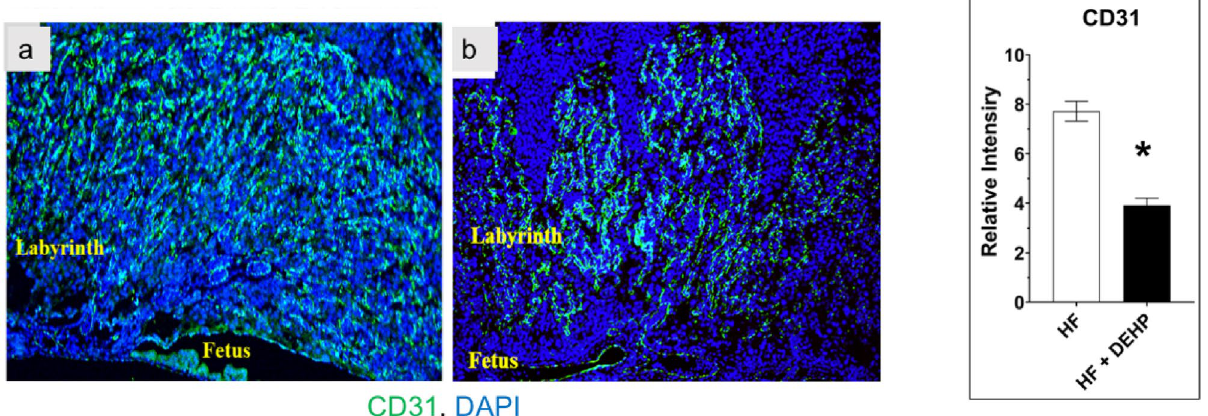
Figure 5. DEHP exposure and HF diet impacts vascularization of the placenta. Left. CD31 immunostaining of placental labyrinth from HF (panel a ) and HF + DEHP ( b ) animals on D13 of pregnancy (10×) are shown. Green indicates immunostaining with CD31 and blue indicates DAPI. Right. ImageJ analysis of CD31 positive cells. The values represent mean ± SEM of five independent samples. Asterisks indicate statistically significant differences *p < 0.05.